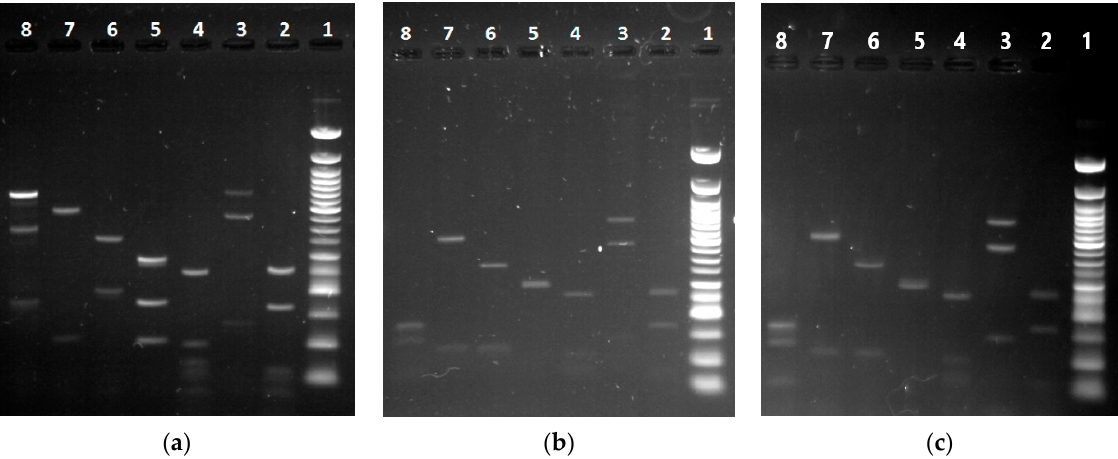
Figure 4. Restriction patterns presented by the reference strains and Penicillium ( P. ) isolates analyzed: ( a ) P. verrucosum . Line 1: 50 bp ladder standard; Lines 2 to 8: restriction fragments formed after digestion by endonucleases Bsp1286 I, Xma I, Hae III, Hinf I, Mse I, Sfc I, and Hpy188 I; ( b ) P. commune . Line 1: 50 bp ladder standard; Lines 2 to 8: restriction fragments formed after digestion by endonucleases Bsp1286 I, Xma I, Hae III, Hinf I, Mse I, Sfc I, and Hpy188 I; ( c ) P. crustosum . Line 1: 50 bp ladder standard; Lines 2 to 8: restriction fragments formed after digestion by endonucleases Bsp1286 I, Xma I, Hae III, Hinf I, Mse I, Sfc I, and Hpy188 I.